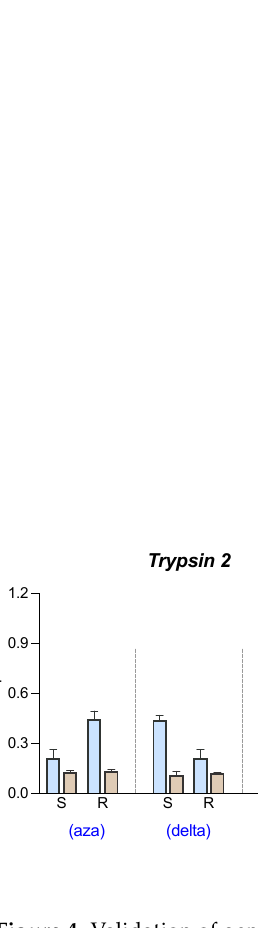
Figure 4. Validation of gene expression levels of bantam, trypsin-2, and trypsin-5 by qPCR analyses. Relative expression is calculated by ∆∆ C T values after normalization with the corresponding endogenous control (mir-2796 for bantam expression and b-tubulin for both trypsin genes). Light blue columns correspond to control sea louse samples, and light brown to samples exposed to the respective drug: “aza” = azamethiphos; “delta” = deltamethrin; “cyper” = cypermethrin. Error bars correspond to standard deviation. S: susceptible population; R: resistant population.